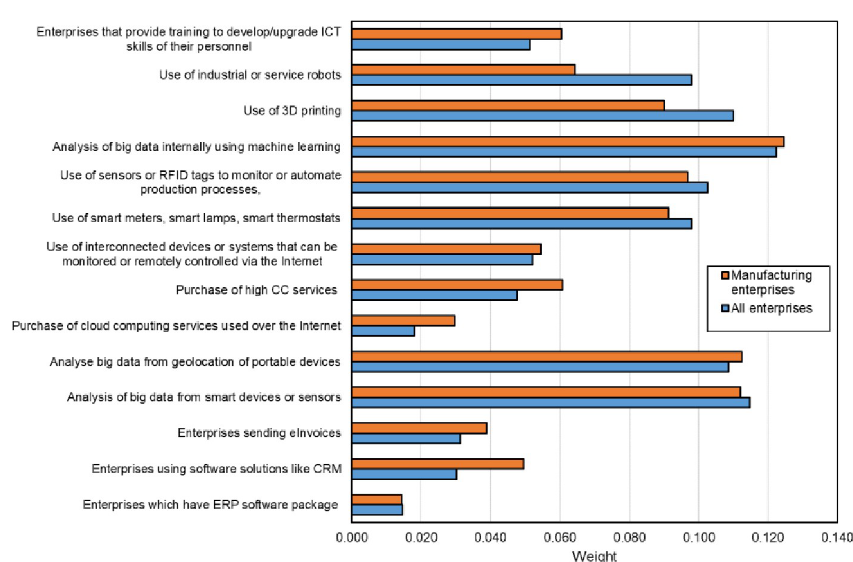
Fig 4. Values of weights for the determinants of digital maturity for all and manufacturing enterprises in the CEE countries.